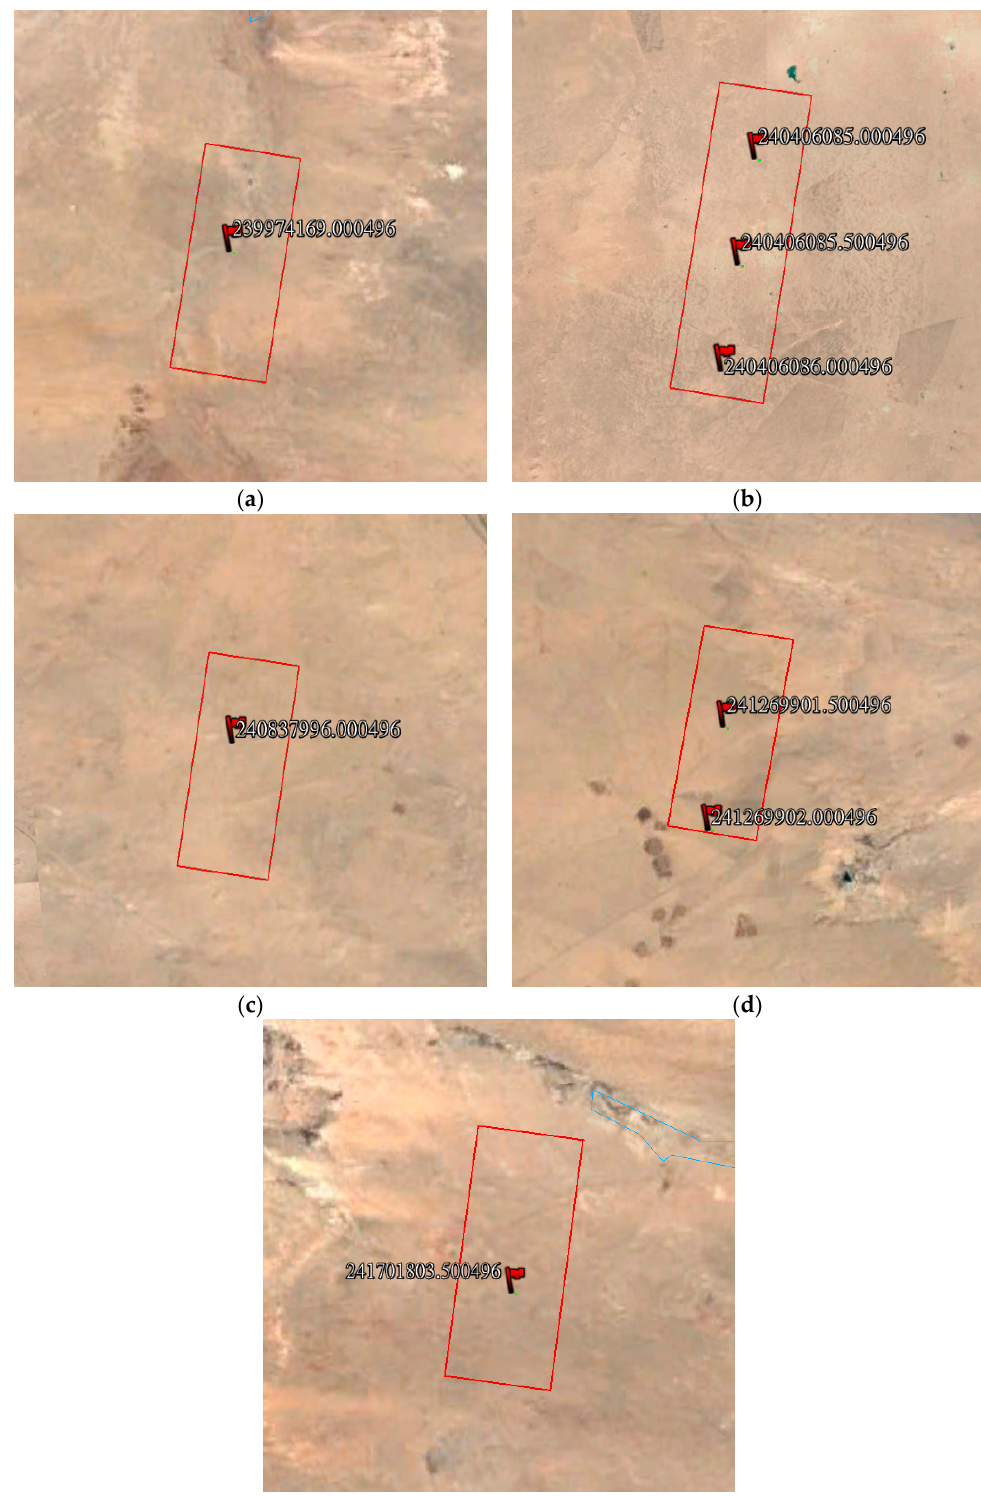
Figure 13. Laser footprint location prediction result; the location of small red flag is the prediction result, and the large red box is the alternative laser detector deploy area: ( a ) 9 August; ( b ) 14 August; ( c ) 19 August; ( d ) 24 August; and ( e ) 29 August.